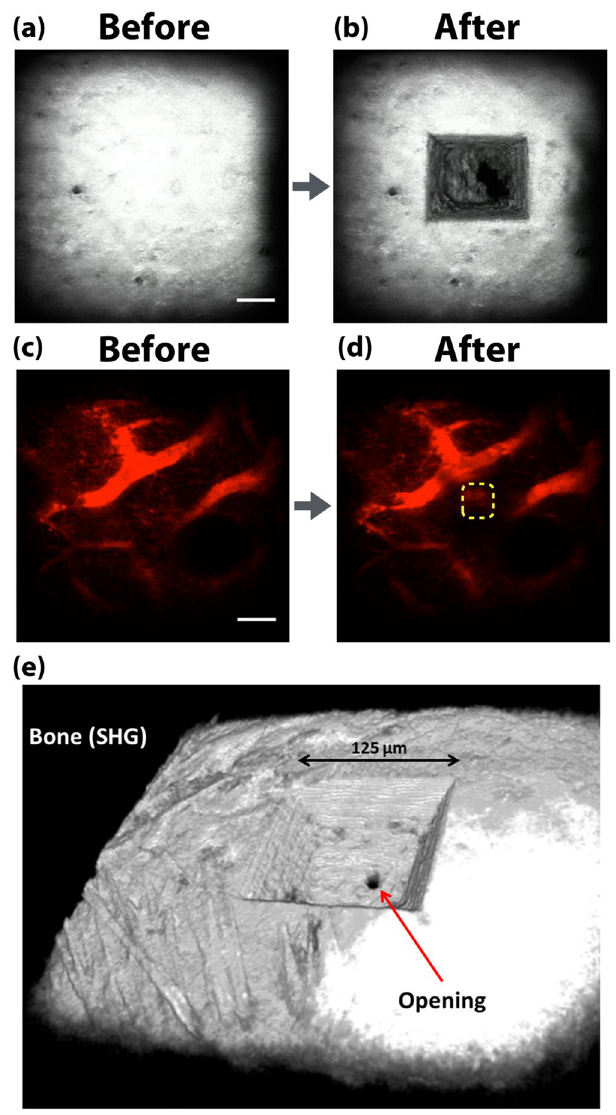
Figure 2. Laser microsurgical bone removal and evaluation of tissue integrity. Images ( a–d ) are maximum intensity projections. Cortical bone images taken before ( a ) and after ( b ) ablation, showing the microchannel channel with the opening to the BM at the bottom. ( e ) Is a 3D reconstructed image of the ablated microchannel. The BM being highly vascularized, the delivery sites are selected to minimize damage to the vasculature during femtosecond laser ablation. Vasculature images taken before ( c ) and after ( d ) ablation, showing the intact blood vessels adjacent to the ablation site. White: SHG, Red: Rhodamine-6G,70kD dextran. Scale bars 50 μ